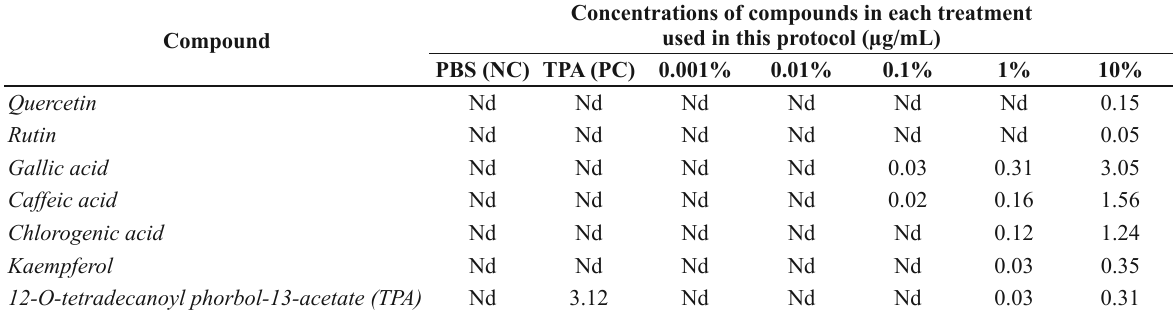
Figure 1c . When evaluating the mitotic index, we observed that samples containing higher amounts of TPA had higher rates of cell multiplication, as demonstrated by a cell’s increase in mitotic indices. Figure 1b indicates the cell viability means ranged from 0.33 ± 0.57% to 6.0 ± 1.0%. The effects of TPA also were re fl ected in these samples by increased